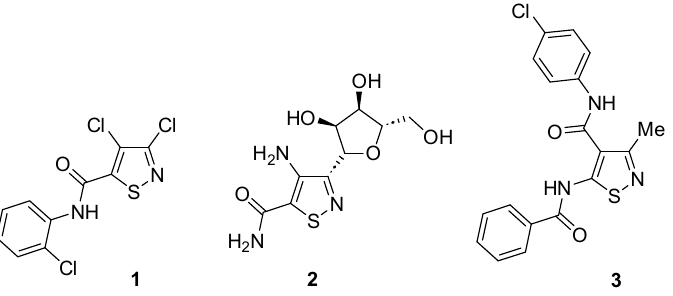
Figure 1. Biologically active isothiazole carboxamides.